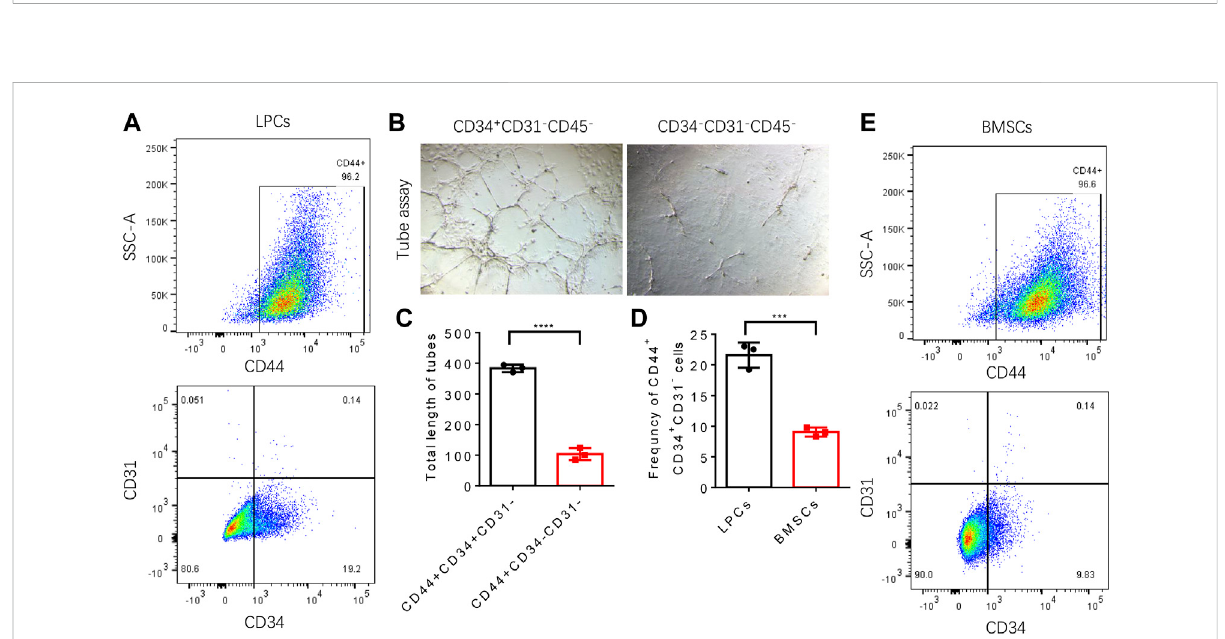
FIGURE 5 Angiogenic function of CD44 + CD34 + CD31 − LPCs. (A) Representative fl ow cytometry plots show the percentage of CD44 + CD34 + CD31 − LPCs. (B) Representativemicrophotographsofcapillary-liketubesformedbyinducedCD44 + CD34 + CD31 − LPCsandCD44 + CD34 − CD31 − LPCsonMatrigel in the presence of ECGS media. (C) Total length of tubes structure (Pixels). **** P ＜ 0.0001. (D) Statistic analysis of the frequency of CD44 + CD34 + CD31 − population in LPCs and BMSCs. *** P ＜ 0.0001. (E) Representative fl ow cytometry plots show the percentage of CD44 + CD34 + CD31 −